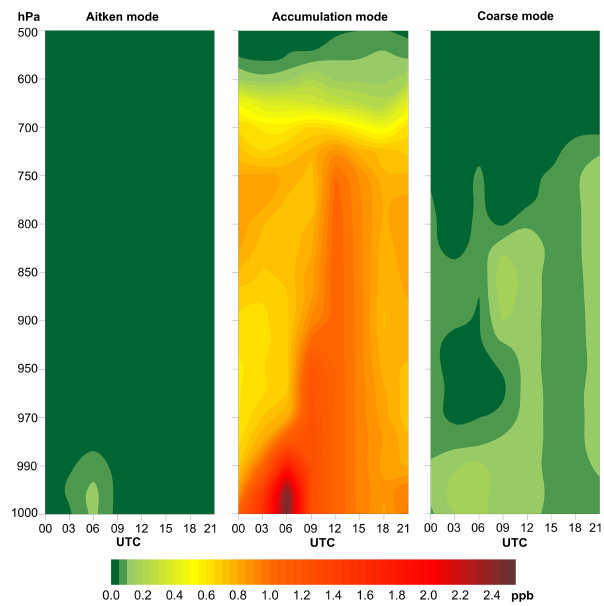
Figure 4. Diurnal variability of the BC concentration at the pres- sure model levels for the Aitken, accumulation, and coarse modes at the Kharkiv sounding station, as an example. The values were calculated as a mean diurnal cycle for the period of